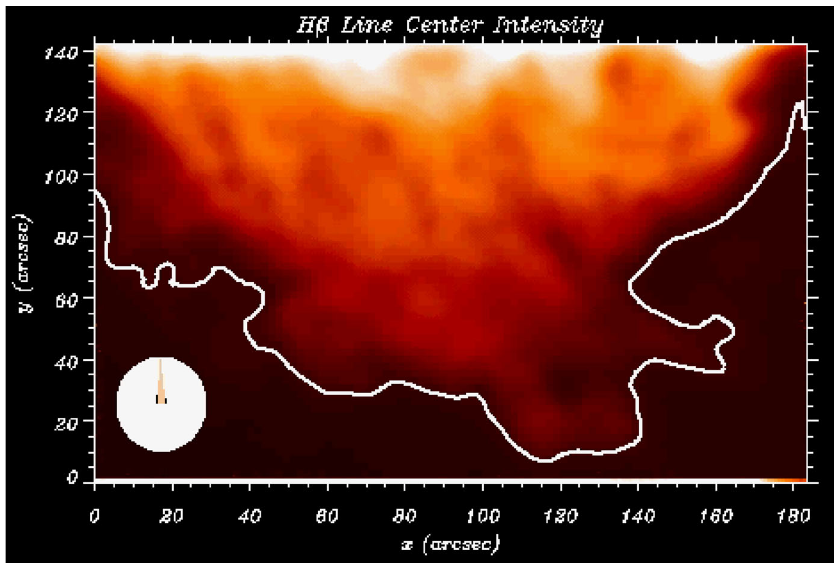
Fig. 21 Still from a movie showing H β line centre images of a quiescent prominence observed with the VTT of Sacramento Peak Observatory. Images have been coaligned and a persistent drift towards the left has been suppressed. The thick white line displays the prominence edge and the solar photosphere is at the top (from Terradas et al. 2002). (To watch the movie, please go to the online version of this review article at doi:10.1007/s41116-018-0012-6)